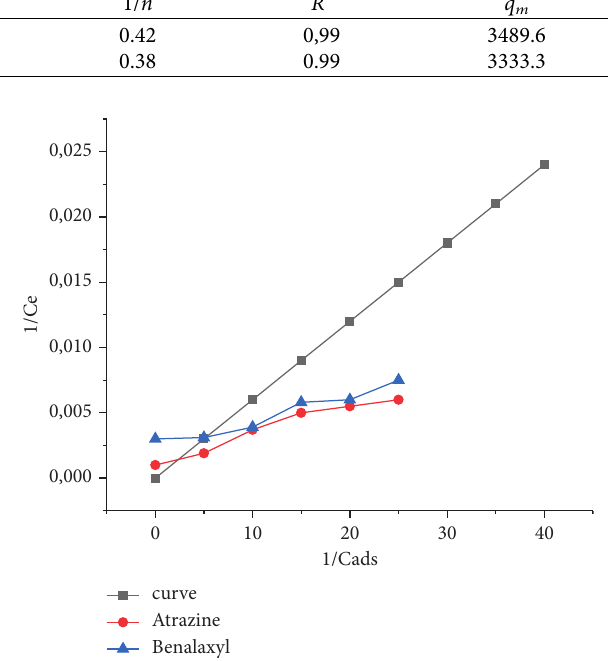
Table 5: Adsorption parameters for adsorption of benalaxyl and atrazine in coal FAPP (Kosovo A). Pesticides